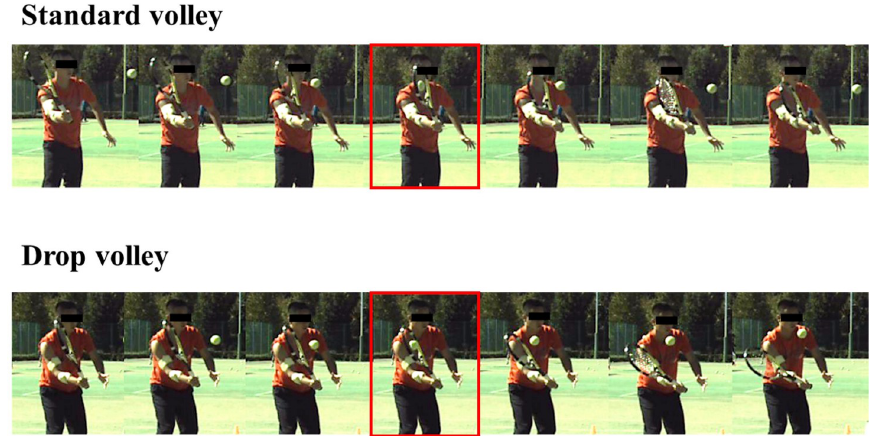
Fig 3. A series of photographs of the racket trajectories in the standard volley and the drop volley in one subject. Red border denoted impact. The pictures surrounded with red are the ball impact.